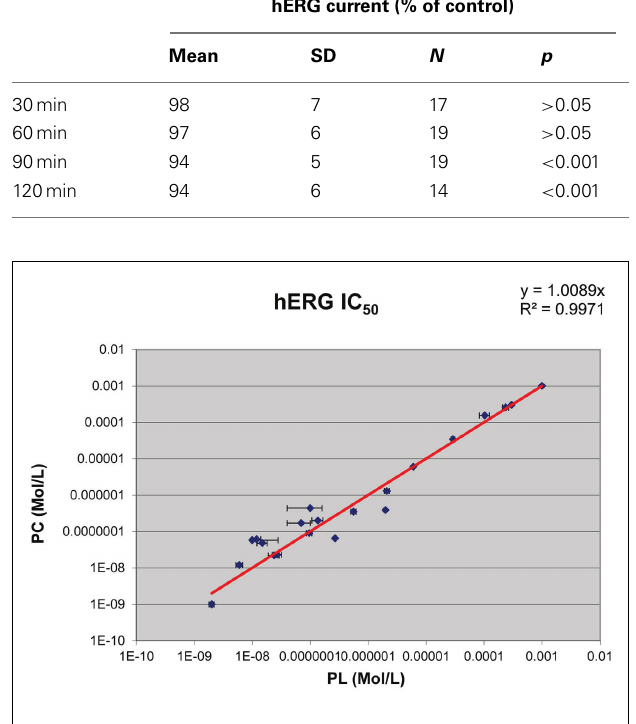
FIGURE 5 | Correlation of the hERG IC 50 values obtained in the automated temperature-controlled Patchliner ® system (PL) with those measured using the conventional manual patch clamp (PC) at